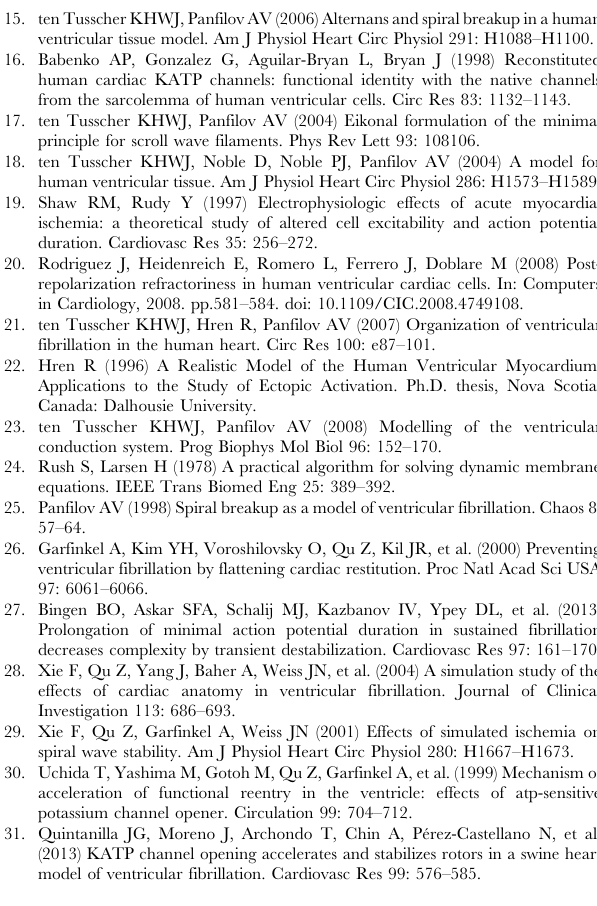
Figure S5 Evolution of hypoxia and hyperkalemia in the course of global ischemia for the patient H060 in [13], estimated by our fitting method. Pink: clinical data on the dominant frequency, averaged over 1 s window with standard deviation. Blue: smoothed curve that we used for our fitting. Red: extracellular potassium concentration. Green: fraction of activated K ATP channels. (TIF) Figure S6 Evolution of hypoxia and hyperkalemia in the course of global ischemia for the patient H062 in [13], estimated by our fitting method. Pink: clinical data on the dominant frequency, averaged over 1 s window with standard deviation. Blue: smoothed curve that we used for our fitting. Red: extracellular potassium concentration. Green: fraction of activated K ATP channels. (TIF) Figure S7 Evolution of hypoxia and hyperkalemia in the course of global ischemia for the patient H063 in [13], estimated by our fitting method. Pink: clinical data on the dominant frequency, averaged over 1 s window with standard deviation. Blue: smoothed curve that we used for our fitting. Red: extracellular potassium concentration. Green: fraction of activated K ATP channels. (TIF) Figure S8 Evolution of hypoxia and hyperkalemia in the course of global ischemia for the patient H064 in [13], estimated by our fitting method. Pink: clinical data on the dominant frequency,